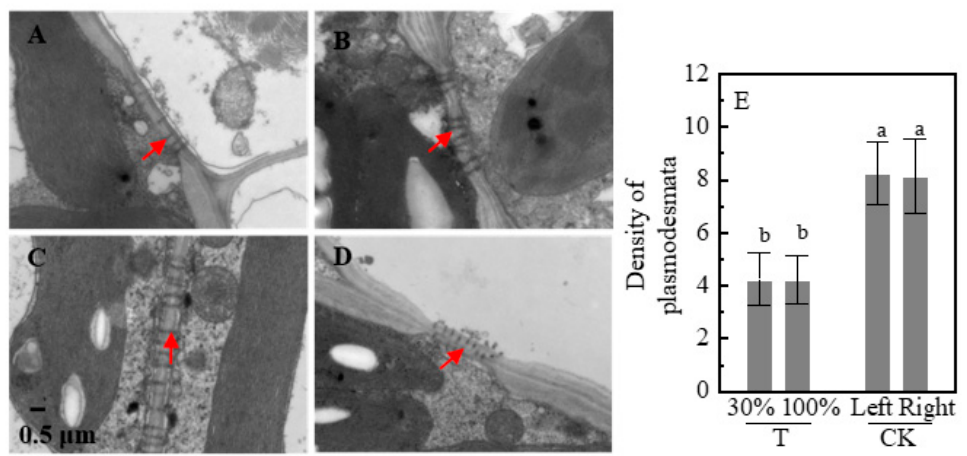
Figure 6. Plasmodesma density of vascular bundle sheath cells and vascular parenchyma cells of the leaves in shading treatments. Scale bar, 0.5 µ m. The arrows point to plasmodesma. Plasmodesma density is the number of plasmodesma within five µ m of the vein. ( A ): T-30%; ( B ): T-100%; ( C ): CK-left; ( D ): CK-right; ( E ): density plasmodesmata. Plants grown under heterogeneous light (T), the left side leaves were under shade (T-30%) and right side leaf under natural light (T-100%). All leaves were under full sunlight (CK). Data with di ff erent letters are significantly di ff erent ( p < 0.05).